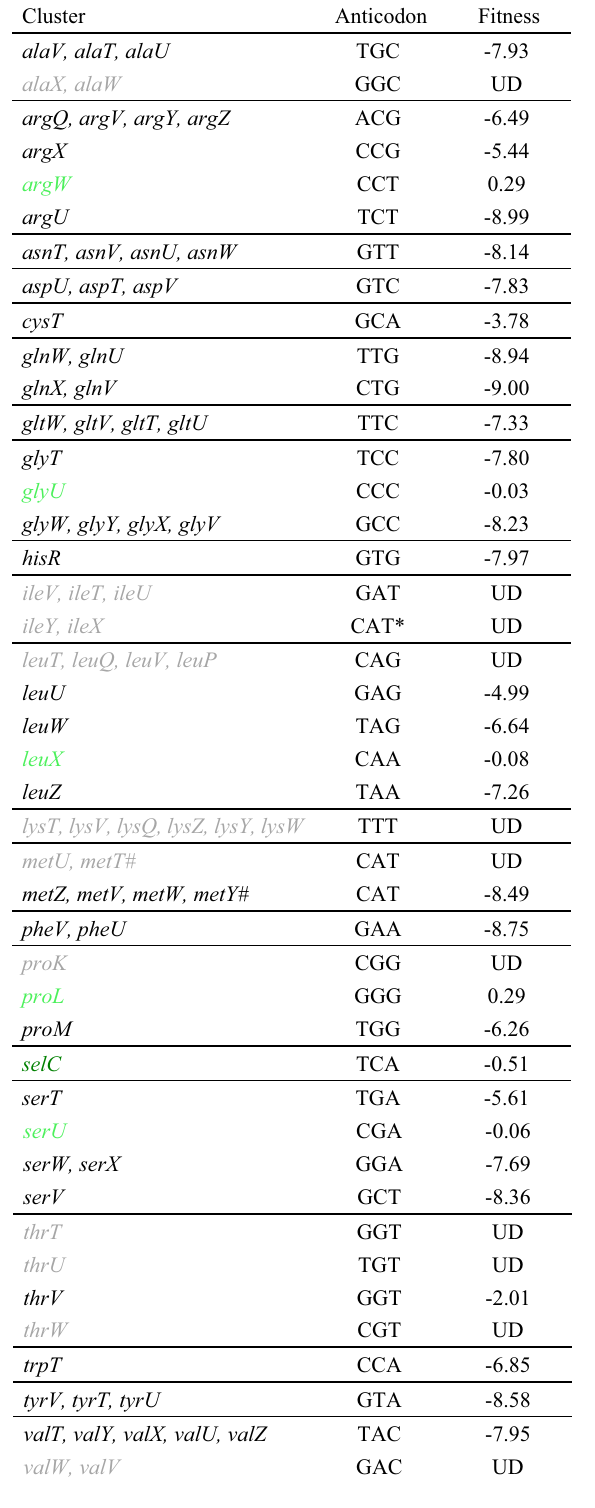
Highlighted are tRNAs not essential to E. coli in rich medium (light green for common tRNAs, deep green for a special tRNA encoded by selC to incorporate an unnatural amino acid) and tRNAs that we failed to design any sgRNAs for (gray). In addition, * the CAT anticodon is modi fi ed with a lysidine at C34 to recognize ATA codon of isoleucine, rather than methionine, # these two clusters of tRNA genes belongs to one tRNA isotype with CAT anticodon, UD undetermined (failure to design